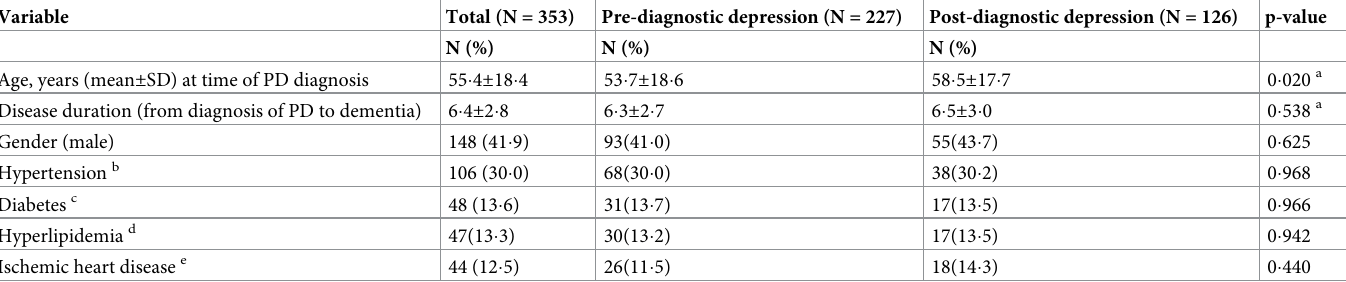
Table 1. Clinical characteristics of PD patients with pre-diagnostic and post-diagnostic